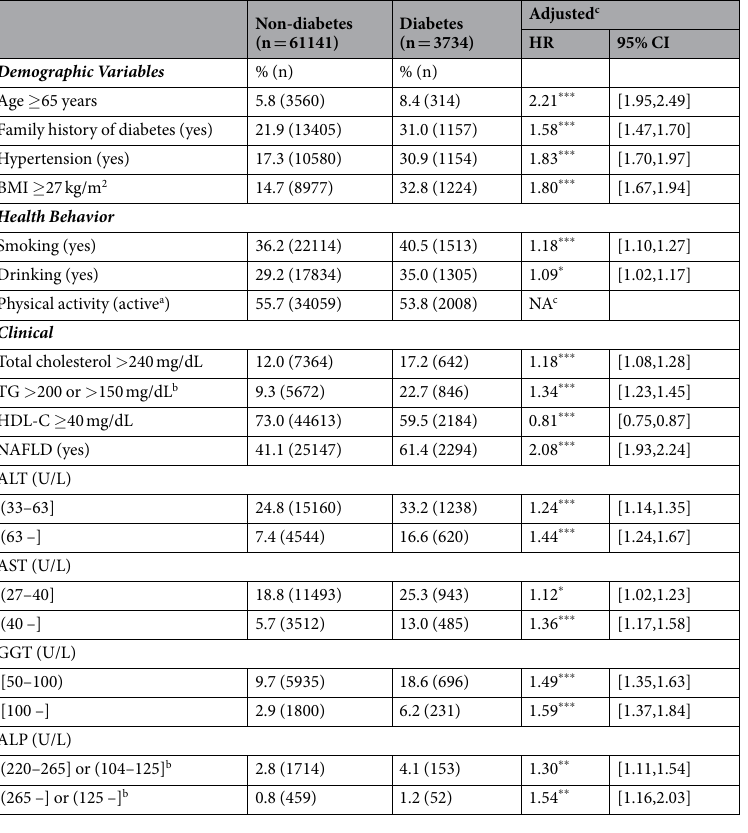
Table 4. Adjusted hazard ratio (HR) of type 2 diabetes in men (stratification for liver-related enzymes). 95% confidence intervals (CI) in brackets. * p < 0.05, ** p < 0.01, *** p < 0.001. Abbreviations: FPG, fasting plasma glucose; TG, triglycerides; HDL-C, high-density lipoprotein cholesterol; NAFLD, non alcoholic fatty acid disease; ALT, alanine transaminase; AST, aspartate transaminase; GGT, gamma-glutamyltransferase; ALP, alkaline phosphatase. a Active: metabolic equivalent of task (MET)-hours per week ≥ 3.75. b Because a new analyzer was used in 2005, the abnormal range for TG is > 200 mg/dL (2000–2004) or > 150 mg/dL (2005-); the cut-points for high ALP are > 220 (2000–2004) or > 104 (2005-) and for extreme high level are > 265 U/L (2000–2004) or > 125 U/L (2005-). c Because the proportional hazard assumption was not satisfied for physical activity, the multiple cox regression model was stratified by physical